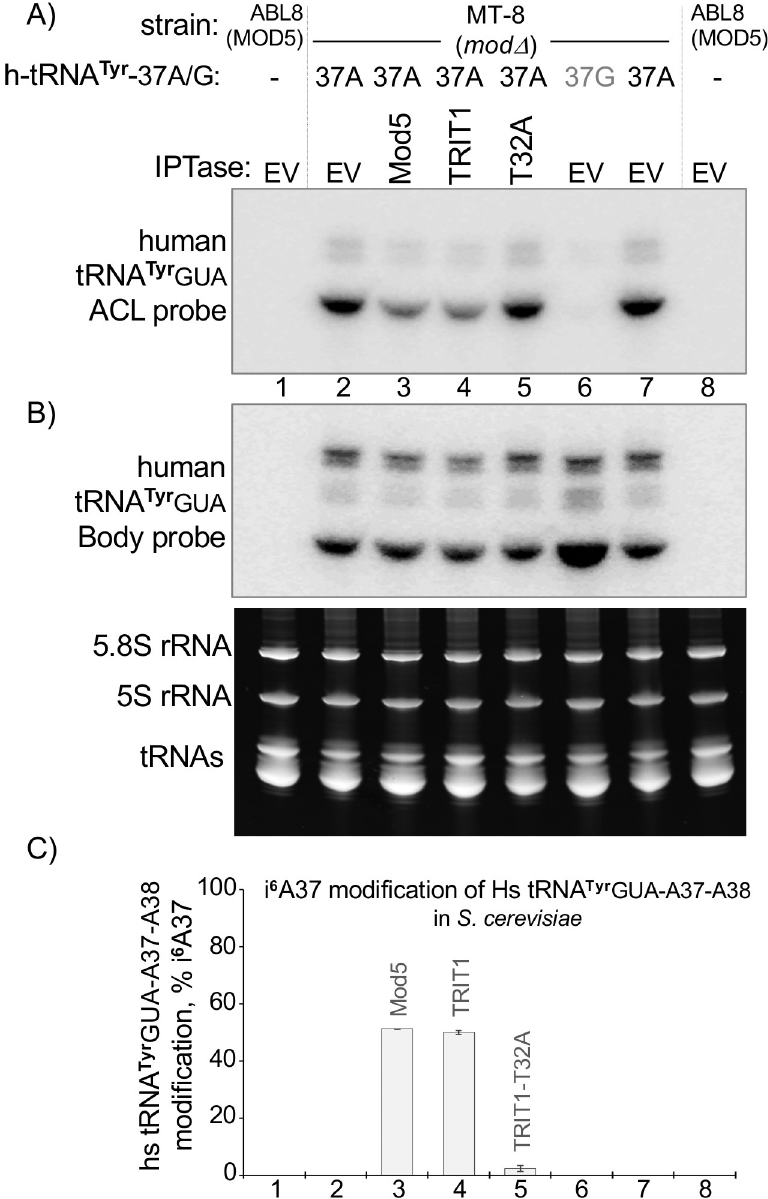
Fig 8. Evidence against a hyper-restriction model for TRIT1. A) Results of PHA6 i 6 A37-sensitive PHA6 northern blot assay after expressing a human nuclear gene for tRNA Tyr GUA-G37-A38 with a G37A point mutant in mod5 Δ MT-8 S . cerevisiae cells (lanes 2–5, 7) and with native G37 (lane 6), in the presence of empty vector (EV) or the IPTases indicated above the lanes (T32A = TRIT1-T32A); lanes 1 and 8 show ABL-8, the MOD5 positive strain. B) Body probe of the blot in A (upper panel), and EtBr stained gel (lower panel). C) Quantitation of % i 6 A37 modification of the cy- tRNA Tyr GUA from biological duplicate PHA6 northern blots as in panels A-B; error bars indicate standard deviation